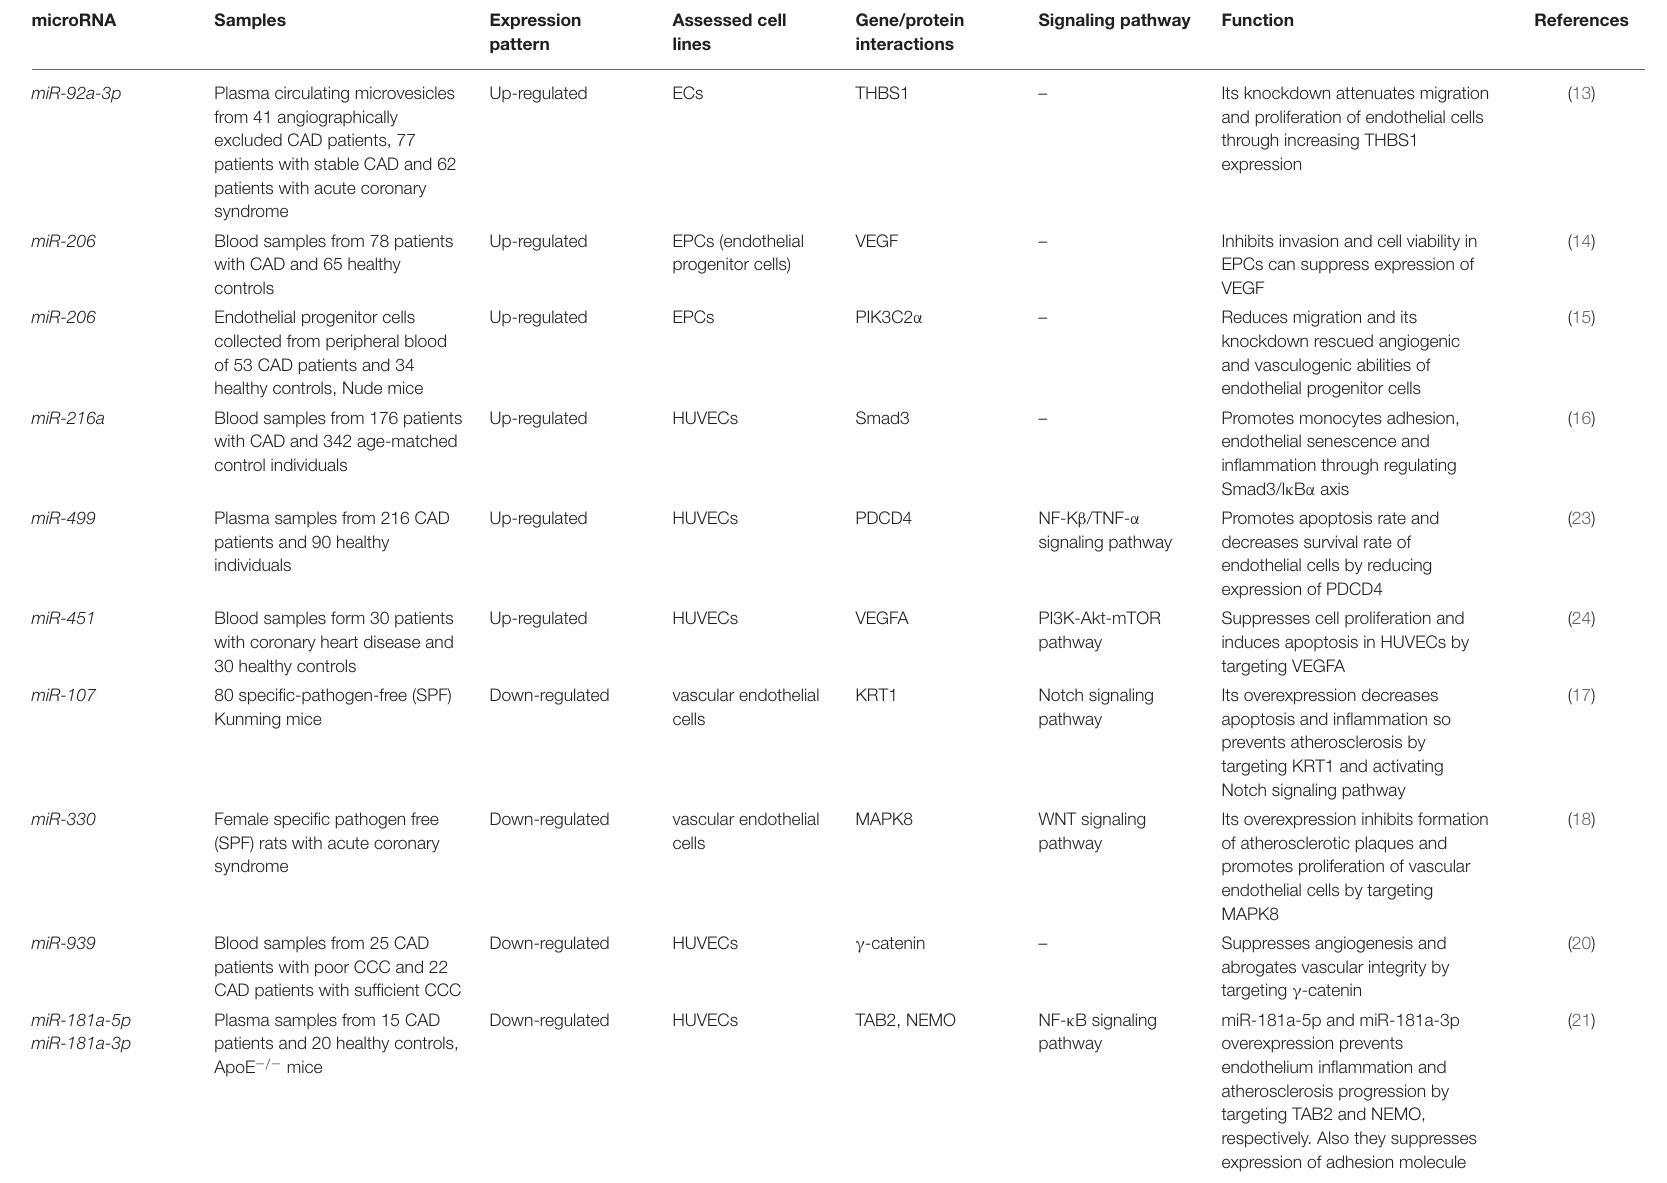
TABLE 1 | CAD-related miRNAs whose function has been assessed in endothelial